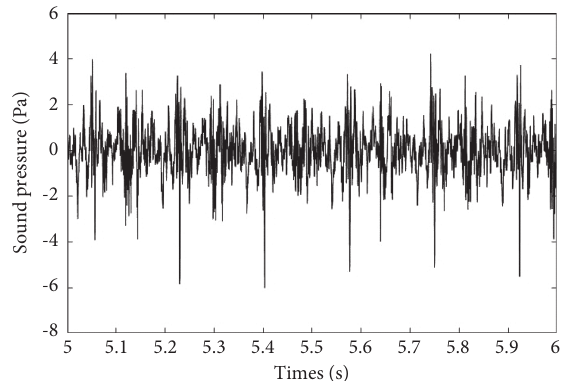
Figure 22: MEEMD reconstruction signal.